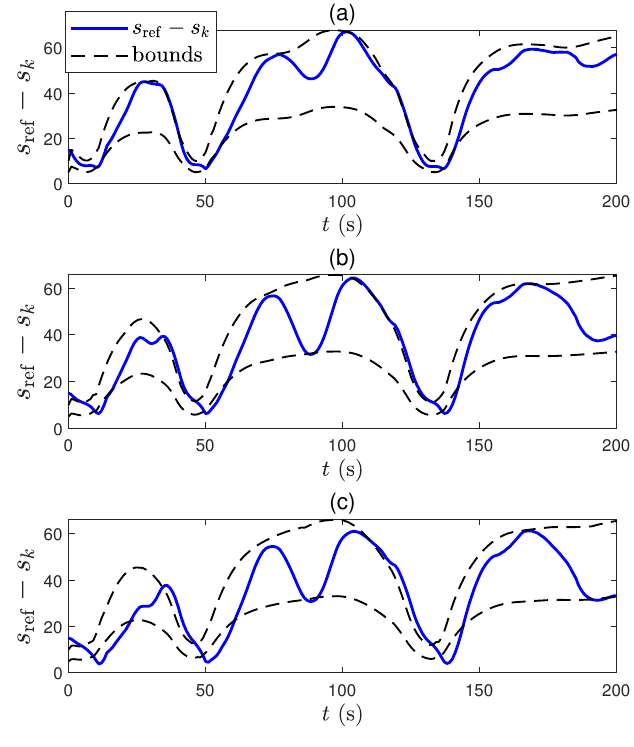
Figure 8. Distance difference between ego car and leader car with ( a ) T s = 1 s, ( b ) T s = 2 s, and ( c ) T s = 3